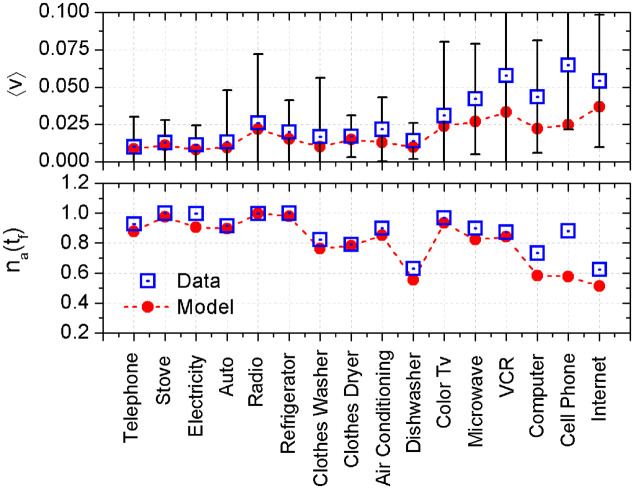
Speed of diffusion, 〈V〉 (top panel) and final fraction of adopters, na(tf) (low panel) for the different technologies.All values have been determined from the onset of the new technology. Squares correspond to the empirical data and circles to the theoretical model. Bars represent the standard deviation. Dotted lines are guides for the eyes.